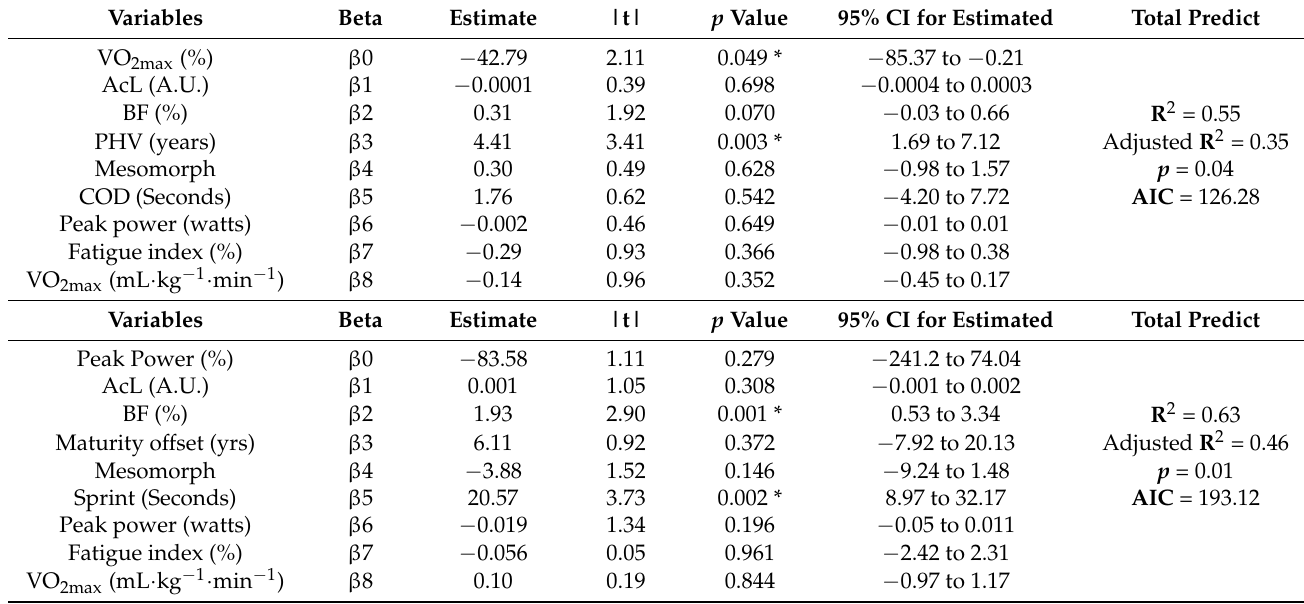
Table 4. Multiple linear regression analysis: percentage of change in VO 2max and peak power with workload, body fat, maturity, somatotype, and baseline fitness